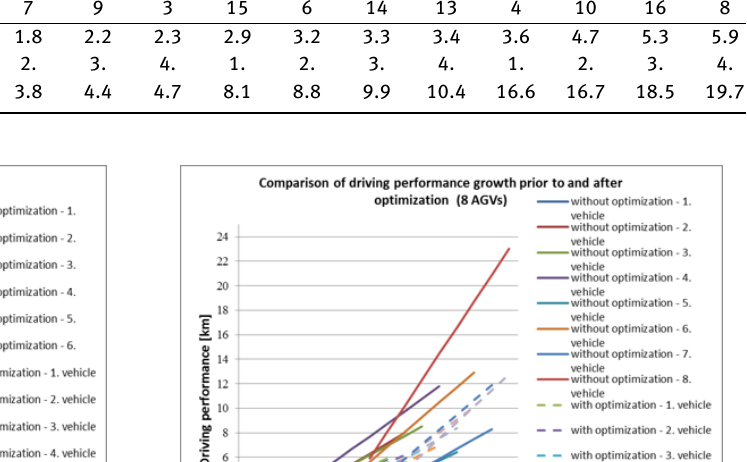
Table 8: The dp i parameter based on sorted distances between V 0 and V i for four AGVs V i